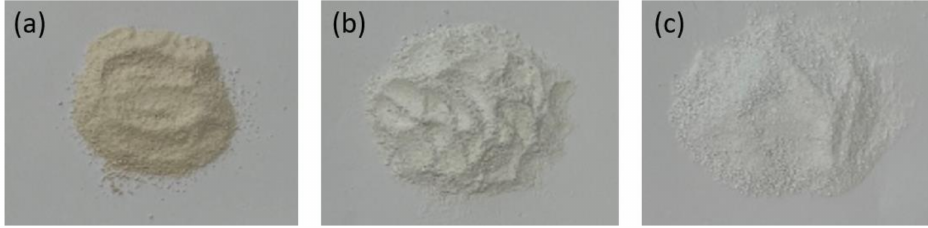
Figure 2. Oyster shell powder heat-treated using plastic working: ( a ) freshly pulverized powder without heat treatment; ( b ) powder after plastic working at 600 ◦ C; and ( c ) powder after plastic working at 1200 ◦ C.